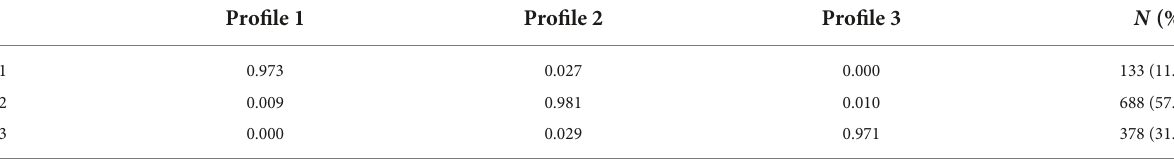
TABLE 3 Average latent class probabilities for most likely class membership (row) by latent class (column).